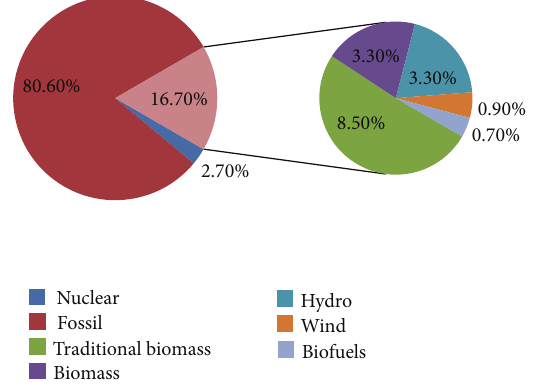
Figure 2: Global energy consumption and share of renewable energy, 2010 [89].